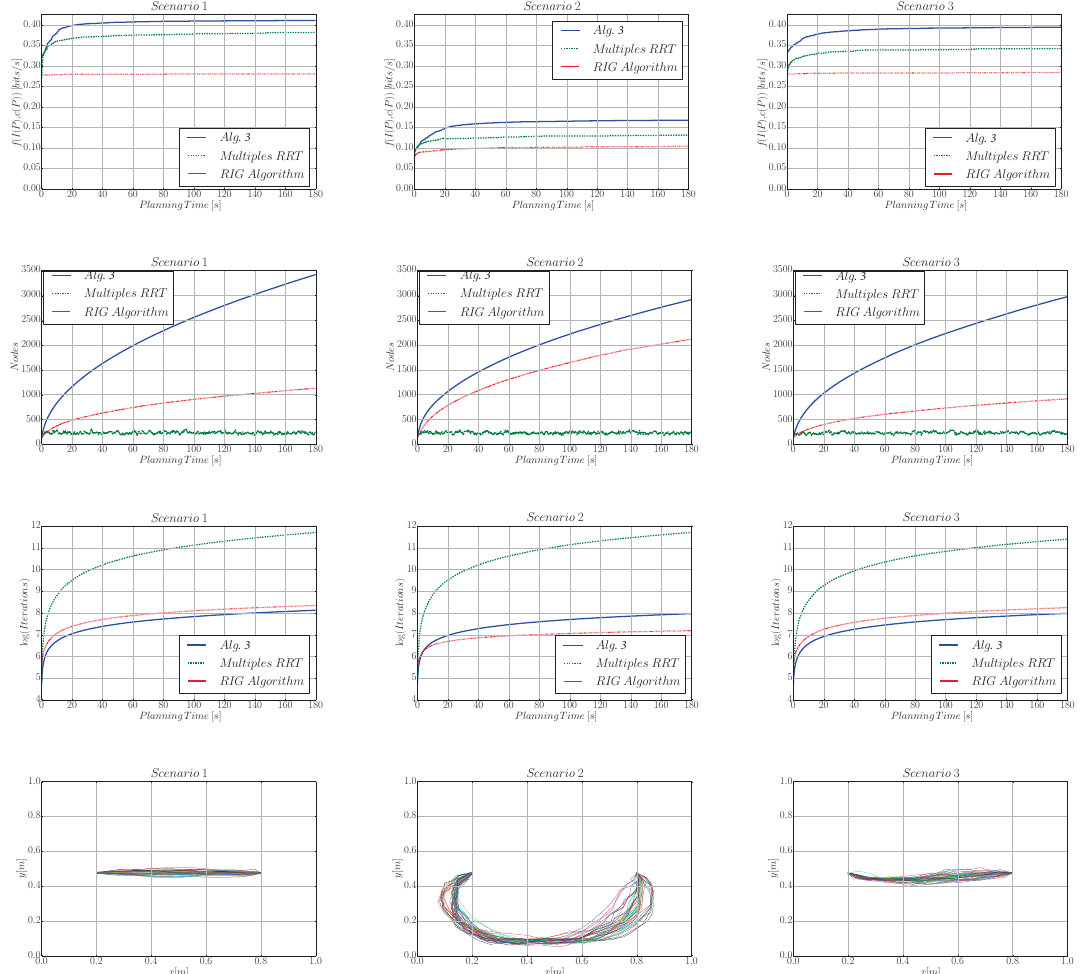
Figure 4. Performance analysis of Algorithm 3 as we increase the planning time. Here, from the first to the last row, we evaluate the utility of the best path, the number of nodes spanned by the tree, and the algorithm’s complexity that is represented as the curve number of iterations vs. planning time. In addition, we plot the 40 paths output by Algorithm 3 given 180 s of planning